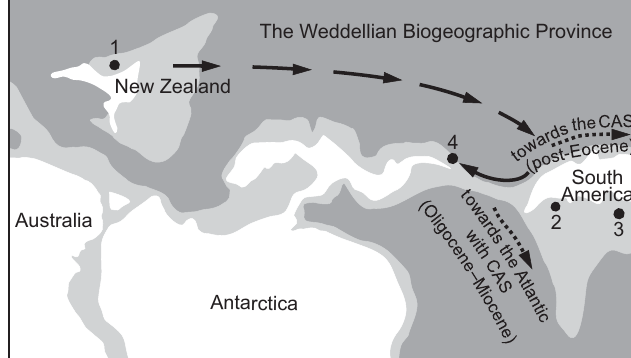
Fig. 8. Paleogene arrangement of Southern Gondwana with distribution of species of Pholadidea in The Weddellian Biogeographic Province from the Late Cretaceous–Paleogene. Abbreviations: 1, Pholadidea ( Hatasia ) wiffe- nae , Campanian–Maastrichtian; 2, Pholadidea frenguellii , Eocene; 3, Pho- ladidea patagonica , Oligocene–early Mio cene; 4, Pholadidea gra dzinskii , Oligocene; CAS, Central American Seaway; full arrows, possible dispersal route of Pholadidea from New Zealand to Antarctica/South America during the latest Cretaceous and the Paleogene (in the latest Cretaceous situation, New Zealand was immediately adjacent to Australia and Antarctica); stip- pled arrows, two possible dispersal routes of Pholadidea out from the Weddellian Biogeographic Province. Map adopted after Clarke and Crame